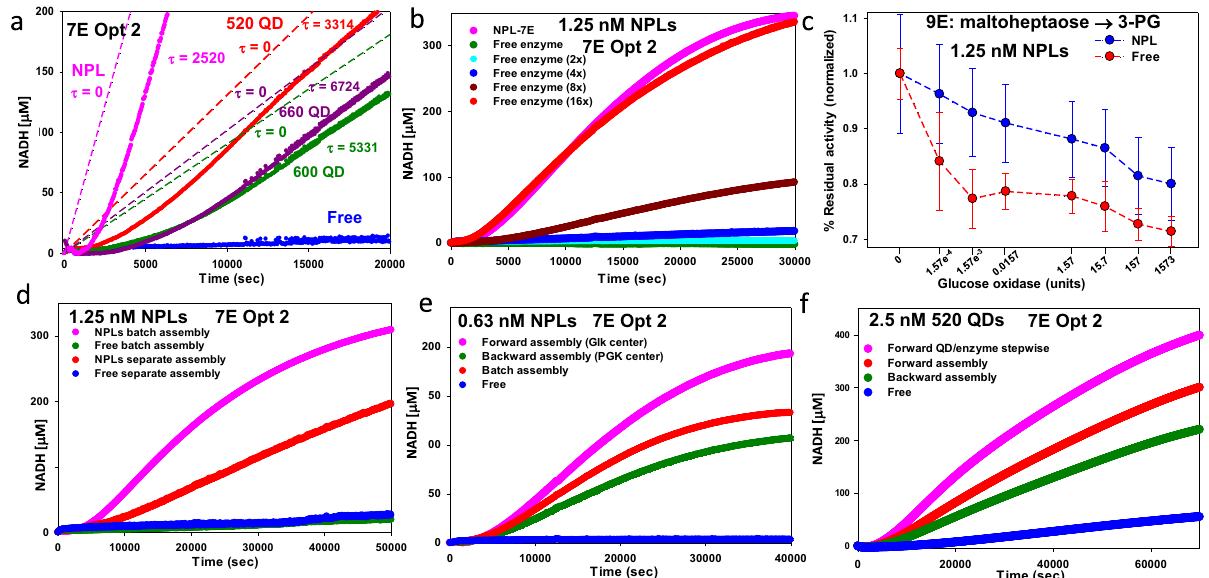
Fig. 5 | Channeling phenomena. a Estimated apparent transient times ( τ , secs) from 7E cascade applied to QD/NPL data of Fig. 3c. Time-dependent product generation shown as solid plots. Linear region (except for the free enzyme, which had none) best fi t with regression to determine τ (x-intercepts). 520 QD τ =3314±26, 600 QD τ =5331±64, 660 QD τ =6724±54, NPL τ =2520±18sec. Dashedlinesshowslopesfrom fi tswith τ =0assumedasobtainedundermaximum channeling. b NPLs with 7E cascade (Opt 2 ratios). Corresponding free enzyme assayedwithsamplescontaining2×,4×,8×,and16×enzymeamountsheldatOpt2 ratios. c NPLs assembled with 9E system (maltoheptaose → 3-PG with 7E at Opt 2 ratios) and corresponding free enzyme assayed with increasing glucose oxidase. NADH turnover normalized for each point and percentage residual activity of the cascade shown. 1.25nM NPL used with ratios of enzyme/NPL in Supplementary Table 2. Data shown is the mean from n =3 independent experimental samples±